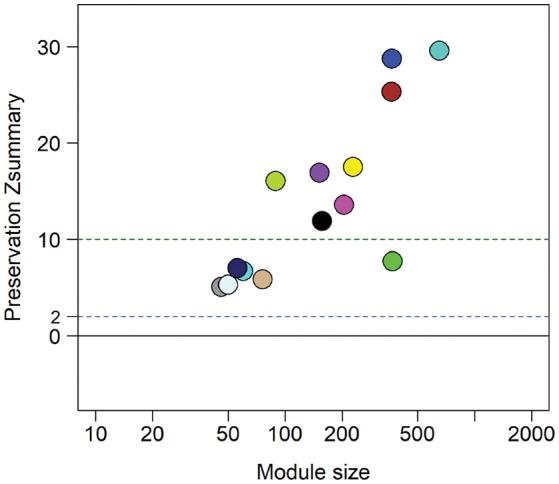
Zsummary statistics reveal module preservation of blood profiles from women with biopsy-confirmed CT/GC-induced endometritis compared to women with biomarker-predicted STI-induced endometritis from independent TECH-N cohort. Colored circles correspond with highly correlated gene modules identified in biopsy-confirmed CT/GC-induced endometritis. The x-axis indicates the number of genes in each module; y axis is the preservation Zsummary value. The dotted lines with cutoff Zsummary of 2 and 10 indicate preservation and high level preservation respectively.